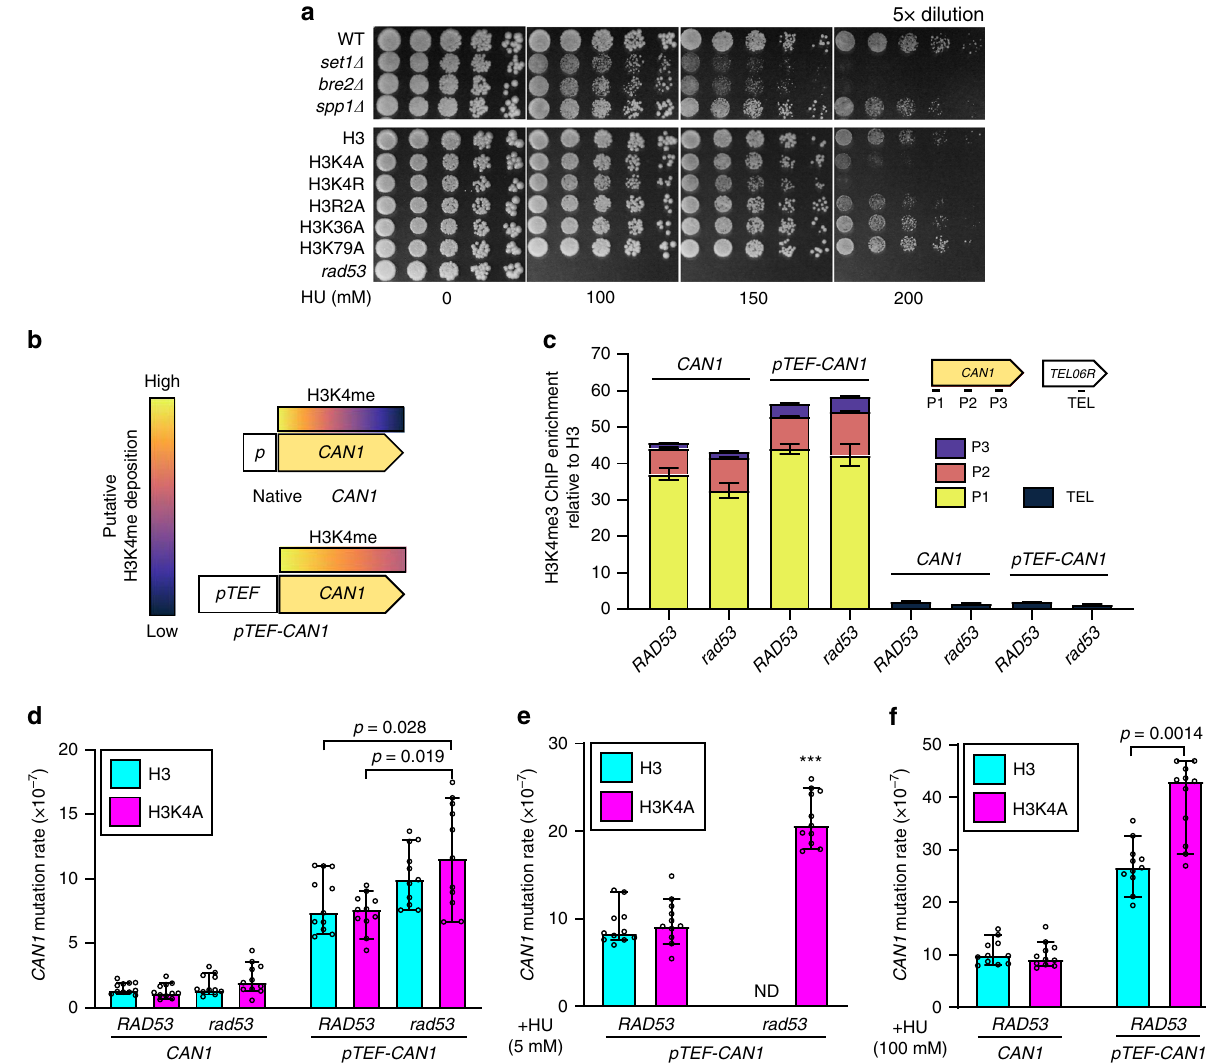
Fig. 7 H3K4 methylation defends the genome from TRCs-mediated instability under replication stress. a HU sensitivity was determined for WT and isogeneic set1 Δ , bre2 Δ , and spp1 Δ strains, as well as the H3 strain and isogeneic H3K4A, H3R2A, H3K36A and H3K79A mutants. b Putative elevated H3K4me and c actual H3K4me3 after pTEF promoter was introduced into the CAN1 gene; error bars represent ± SEM ( n = 3 technical replicates). Mutation rates of d native CAN1 (left panel) and pTEF-CAN1 (right panel) were measured by the fl uctuation test (see Methods section) in RAD53 -H3, RAD53 -H3K4A, rad53- H3 and rad53 -H3K4A cells. rad53 refers to rad53-K227A mutant. As in d , cells were treated by e 5 mM and f 100 mM HU. Data are the median with 95% con fi dence intervals ( n = 11 independent samples). Statistical signi fi cance was determined by Mann – Whitney U -test; p < 0.05; asterisks represent p < 0.001 compared with RAD53 -H3 or RAD53 -H3K4A; ND, not